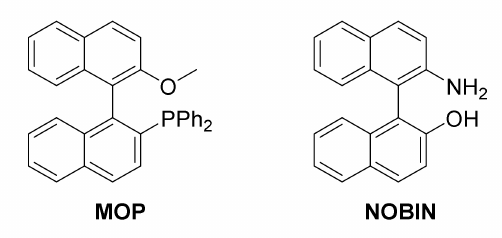
Figure 5. Chemical structure of MOP and